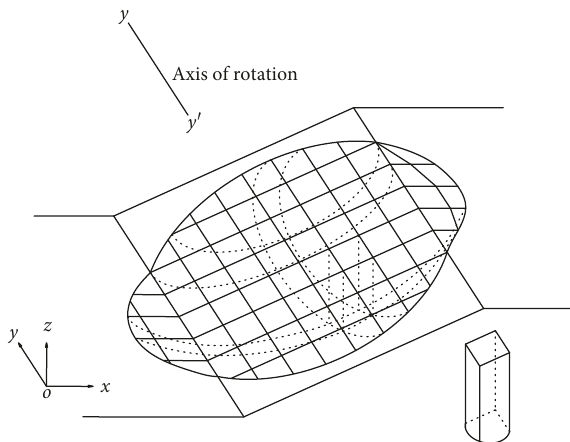
Figure 1: The 3D slip surface and coordinate. Figure